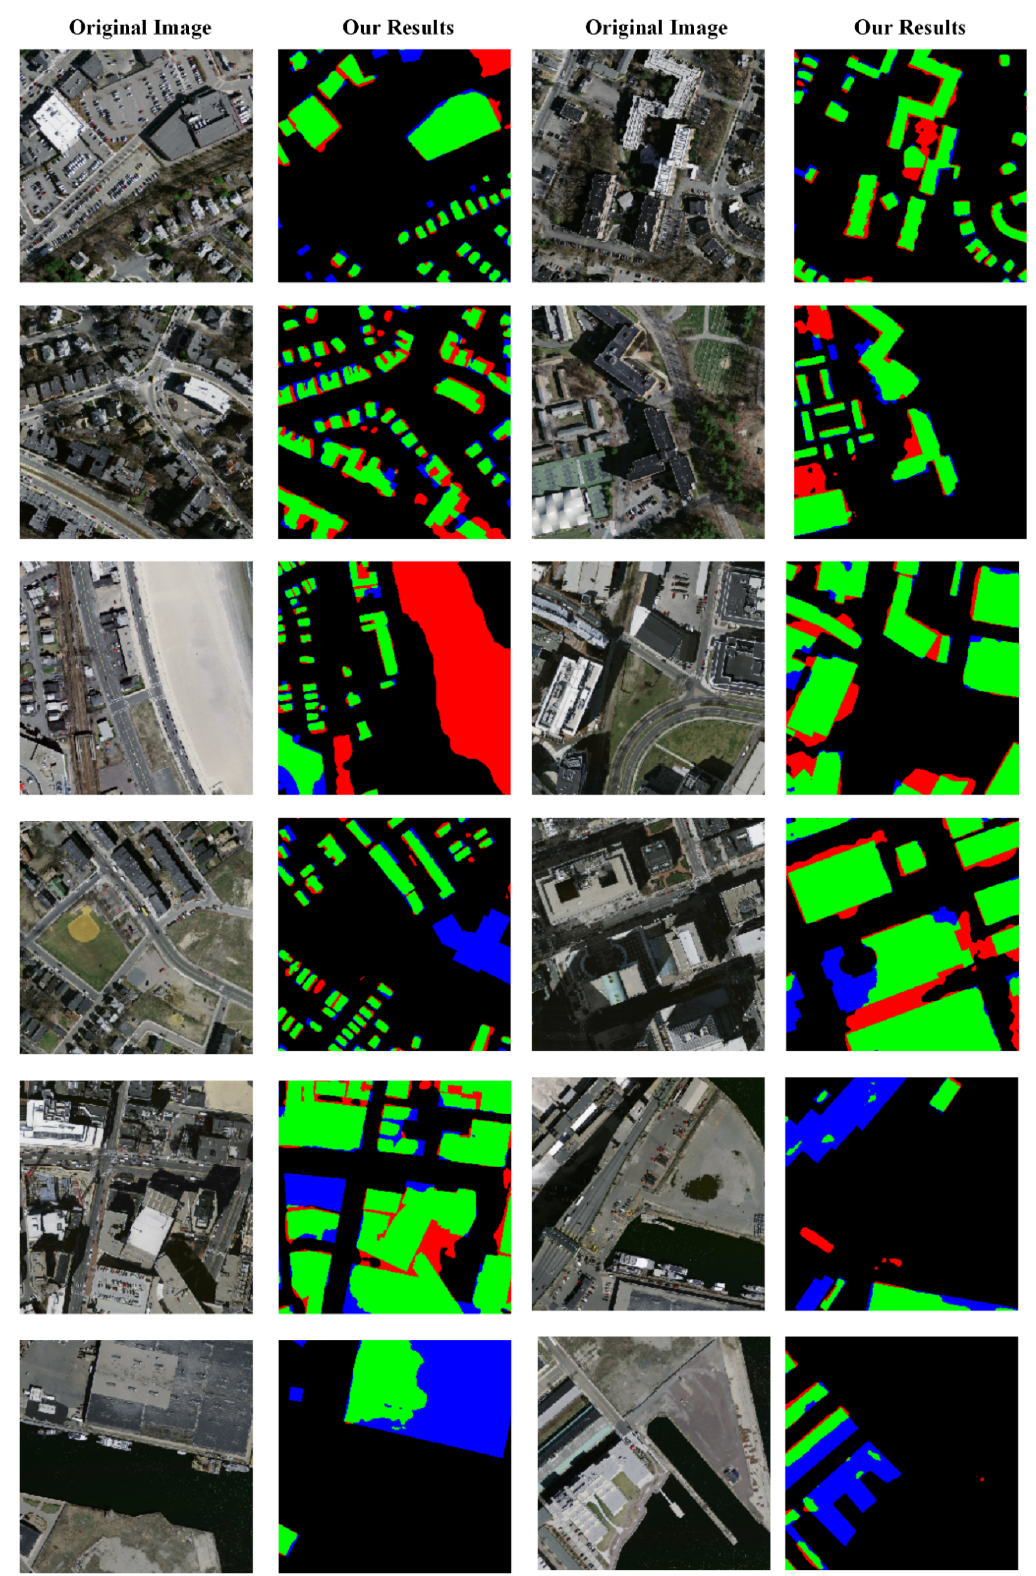
Figure 10. Major false negative exhibitions of our extraction results in the WHU dataset. The green, red and blue areas represent the right, false positive and false negative areas, respectively.